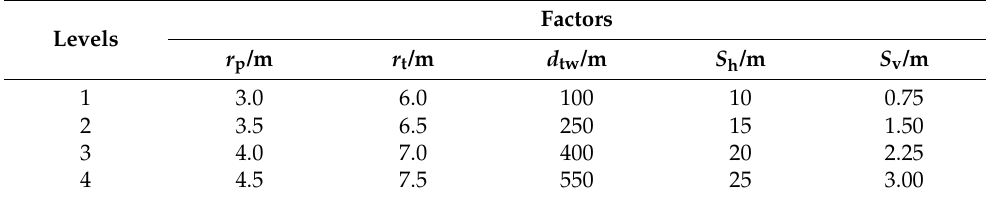
Table 2. Factors and levels in the orthogonal